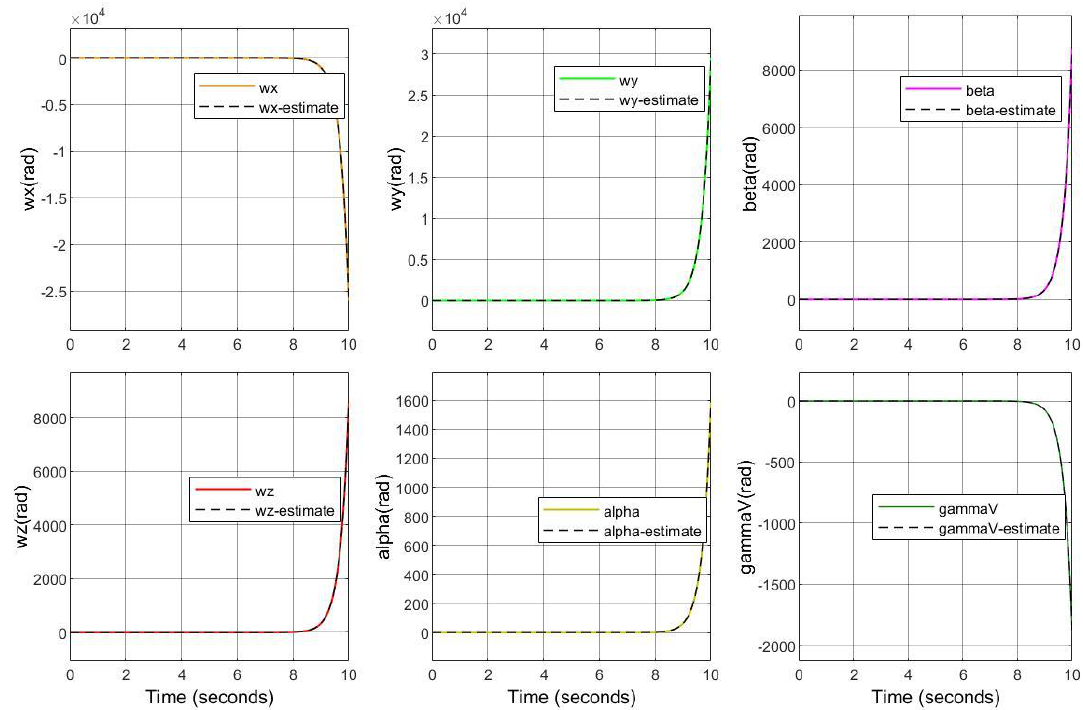
Figure 8. Detection simulation results of actuator stuck fault from input 3.